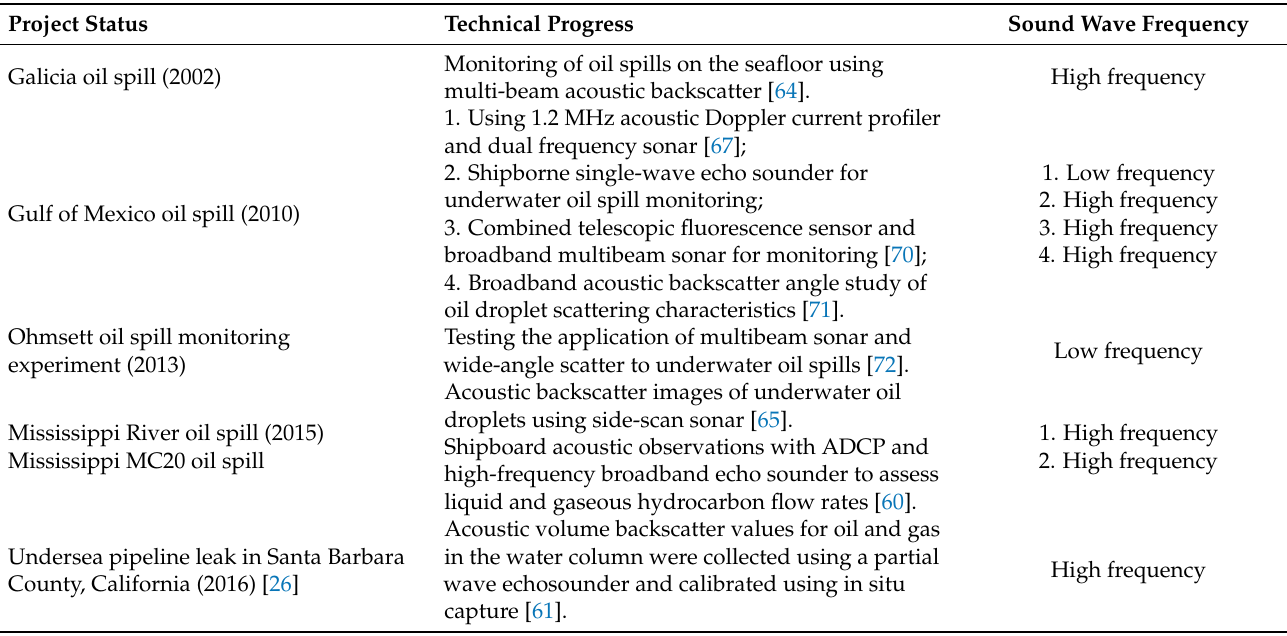
Table 2. Statistics of oil spill monitored by acoustic technology.